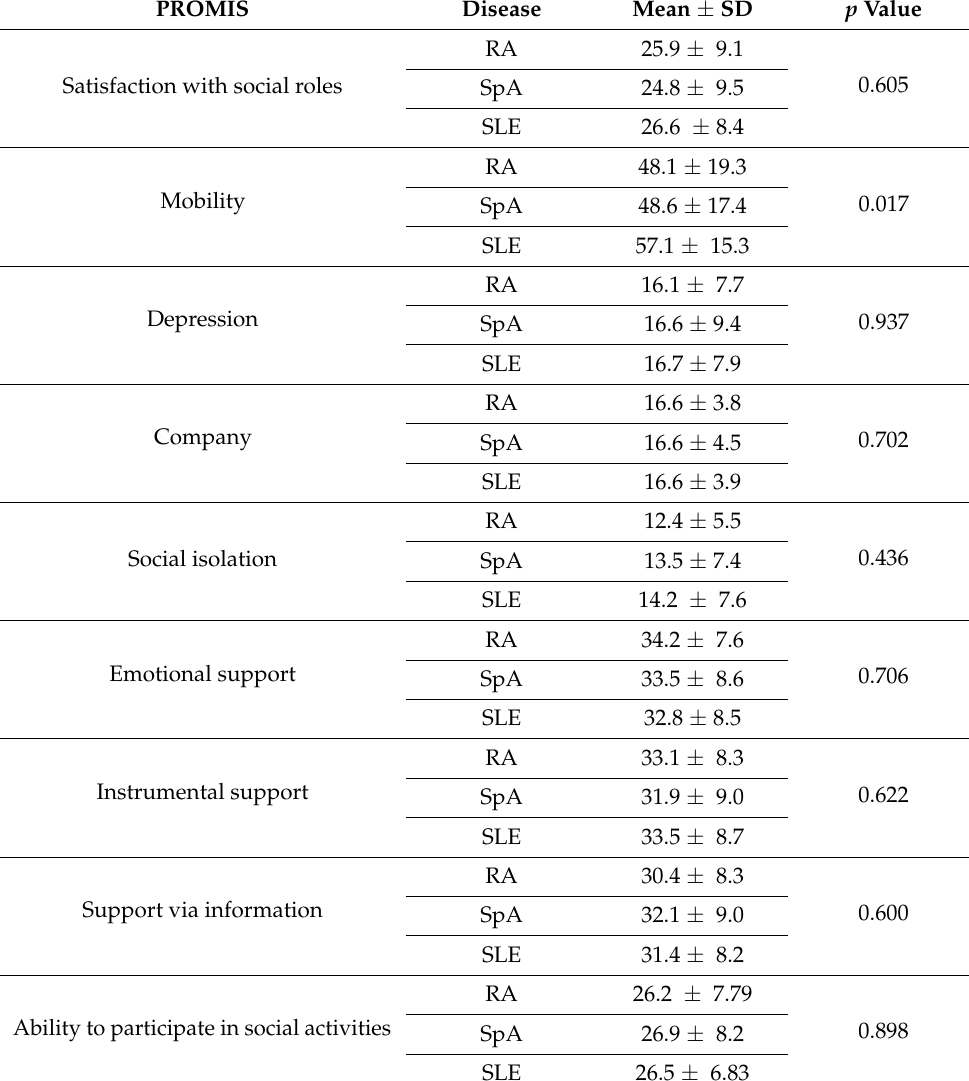
Table 2. Social questionnaires